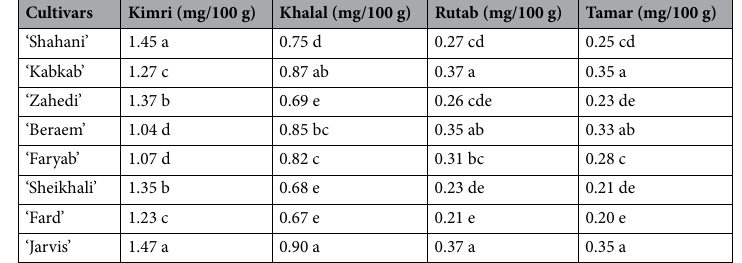
Table 4. Chlorophyll a content of ‘Piarom’ date fruit in kimri, khalal, rutab and tamar stages after pollination with eight pollinating cultivars. Different letters within columns indicate significant differences according to Duncan’s multiple range test (p <